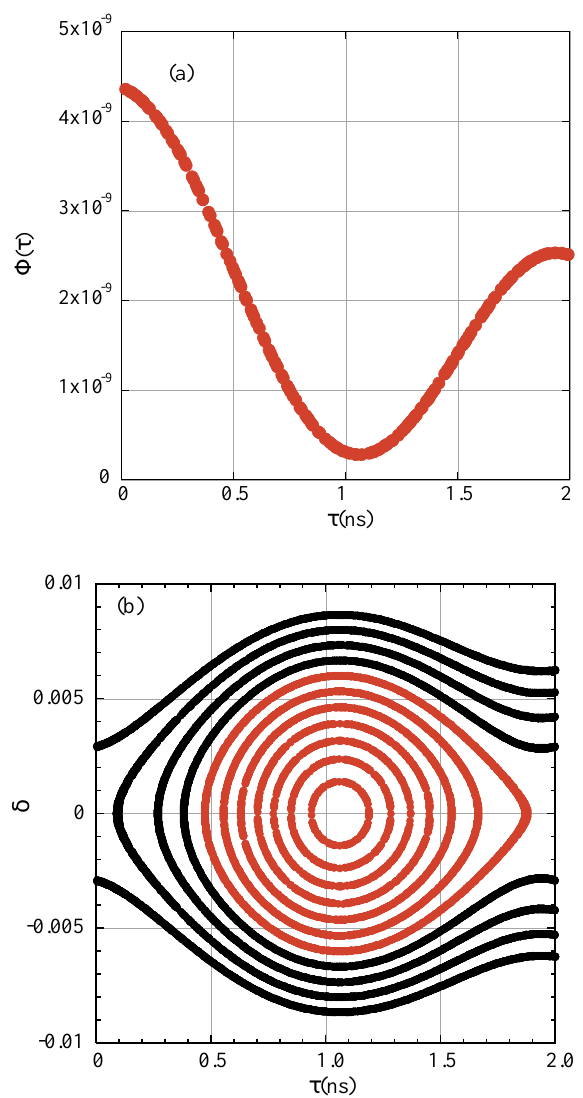
FIG. 2. (Color) (a) The normalized potential energy ignoring the external potential term and (b) the longitudinal phase space for the CESR rf bucket using the parameters in Table I.